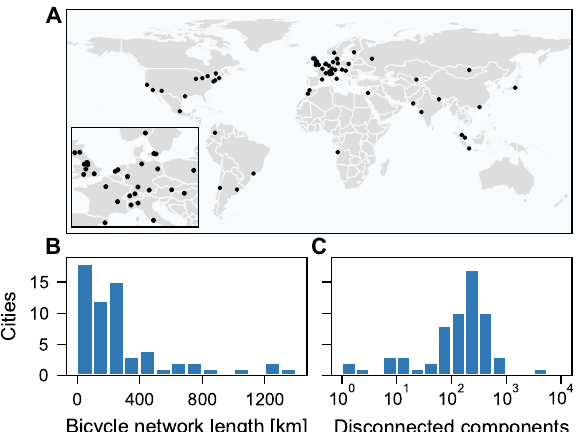
Figure 1. The state of existing bicycle networks. ( A ) We extract street networks from 62 cities covering different regions and cultures; many are considered modern and well developed. ( B ) The distribution of city-wide lengths of bicycle tracks indicates negligible existing cycling infrastructure that is also ( C ) split into hundreds of disconnected components. See more details in Supplementary Table 1. Map created with: https:// github. com/ mszell/ biken wgrow th